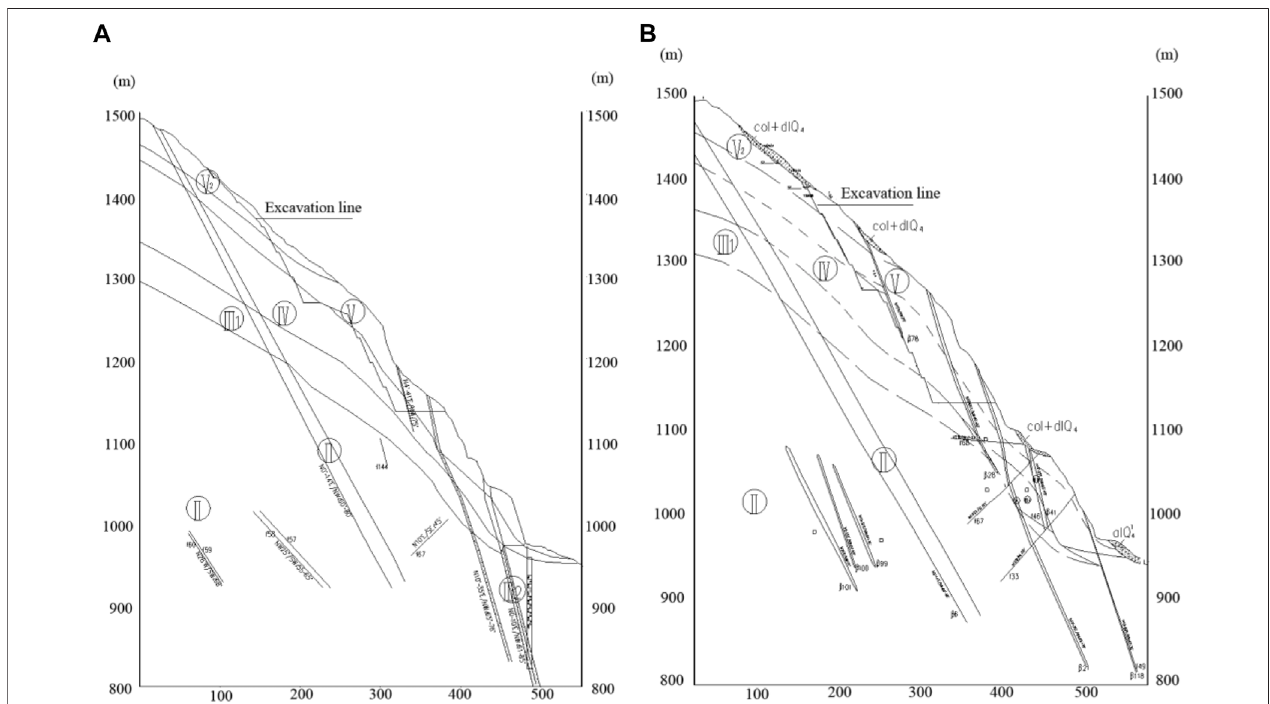
FIGURE 5 | (A) Geological map of LPIII-III section of the left bank slope. (B) Geological map of LPVII-VII section of the left bank slope.